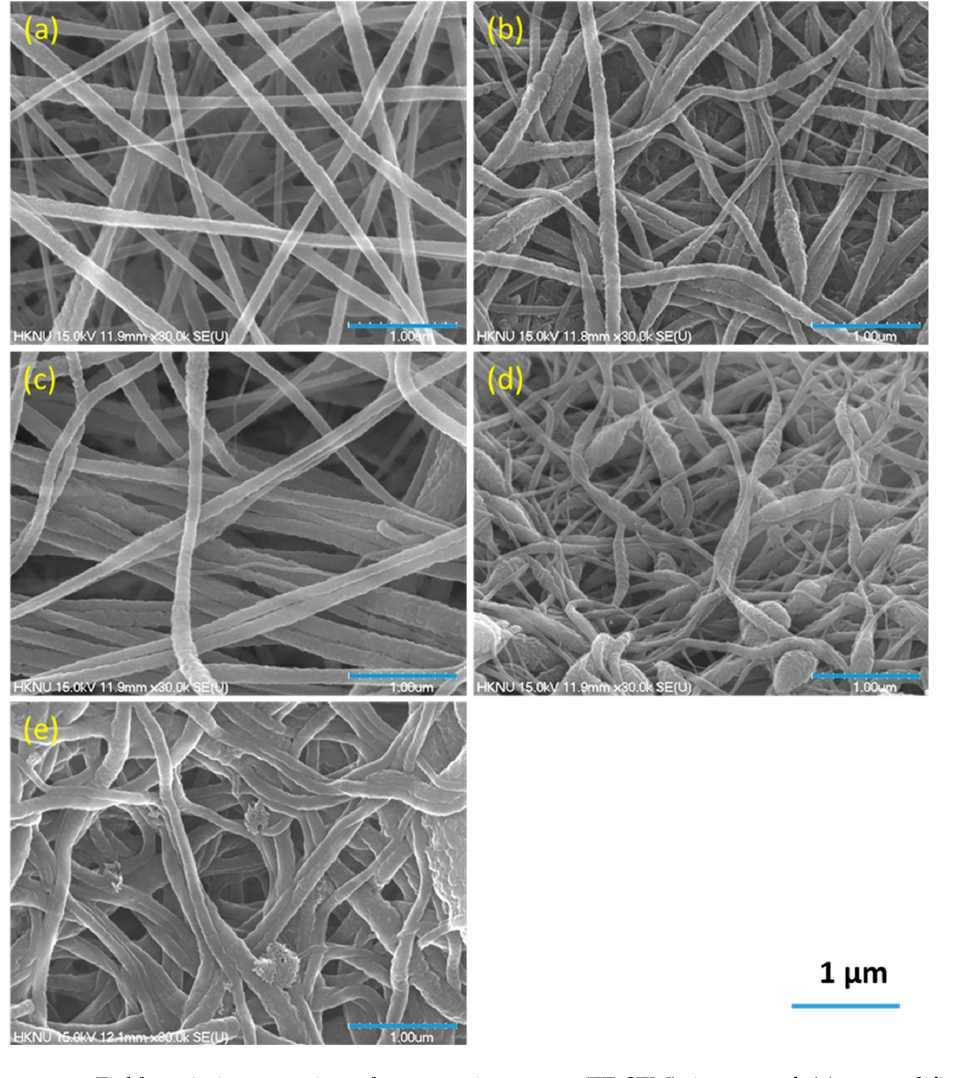
Figure 2. Field emission-scanning electron microscope (FE-SEM) images of ( a ) unmodified polyacrylonitrile (PAN) fiber and PAN fiber with different concentrations of DETA: ( b ) 40% DETA, ( c ), 55% DETA, ( d ) 70% DETA, and ( e ) 85%